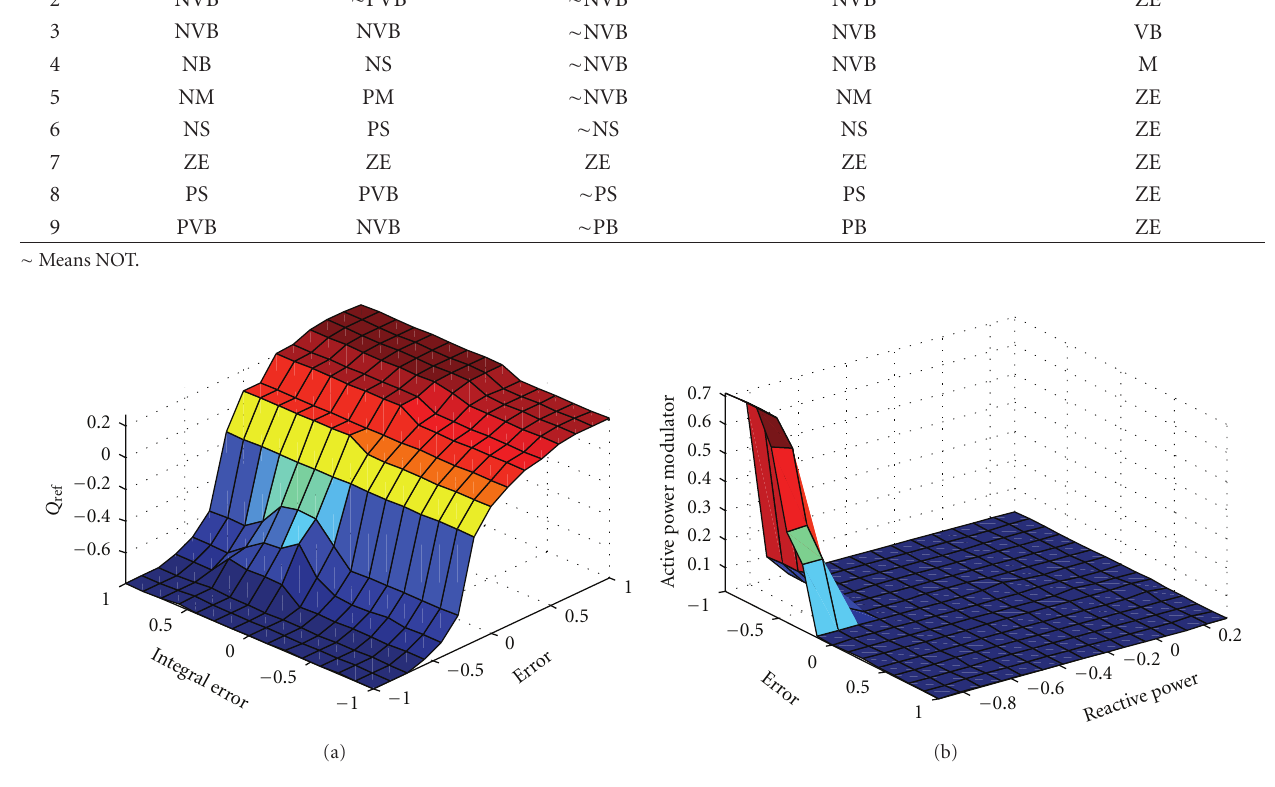
Figure 4: Fuzzy surface of controller for 1.5 MW WT.